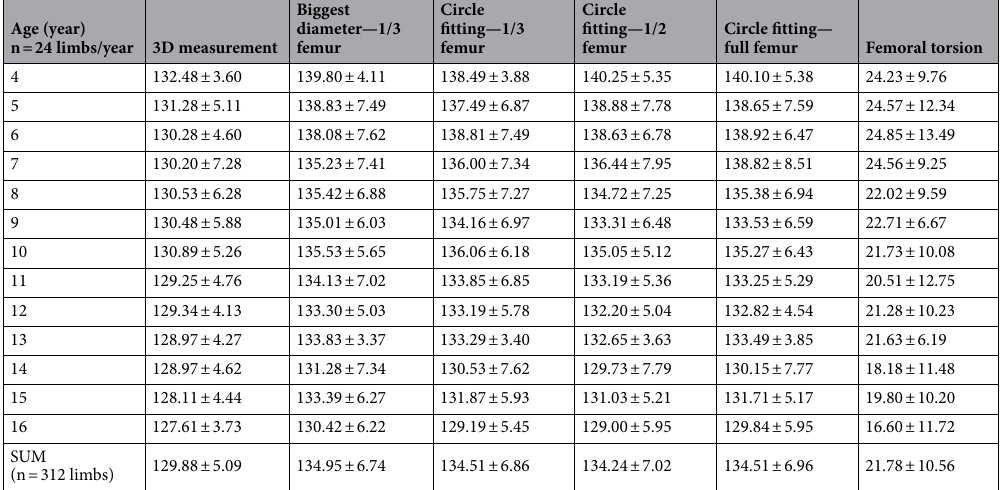
Table 1. Average NSA and femoral torsion results per 3D reconstruction and each 2D NSA measurement method (mean ± S.D., degrees).